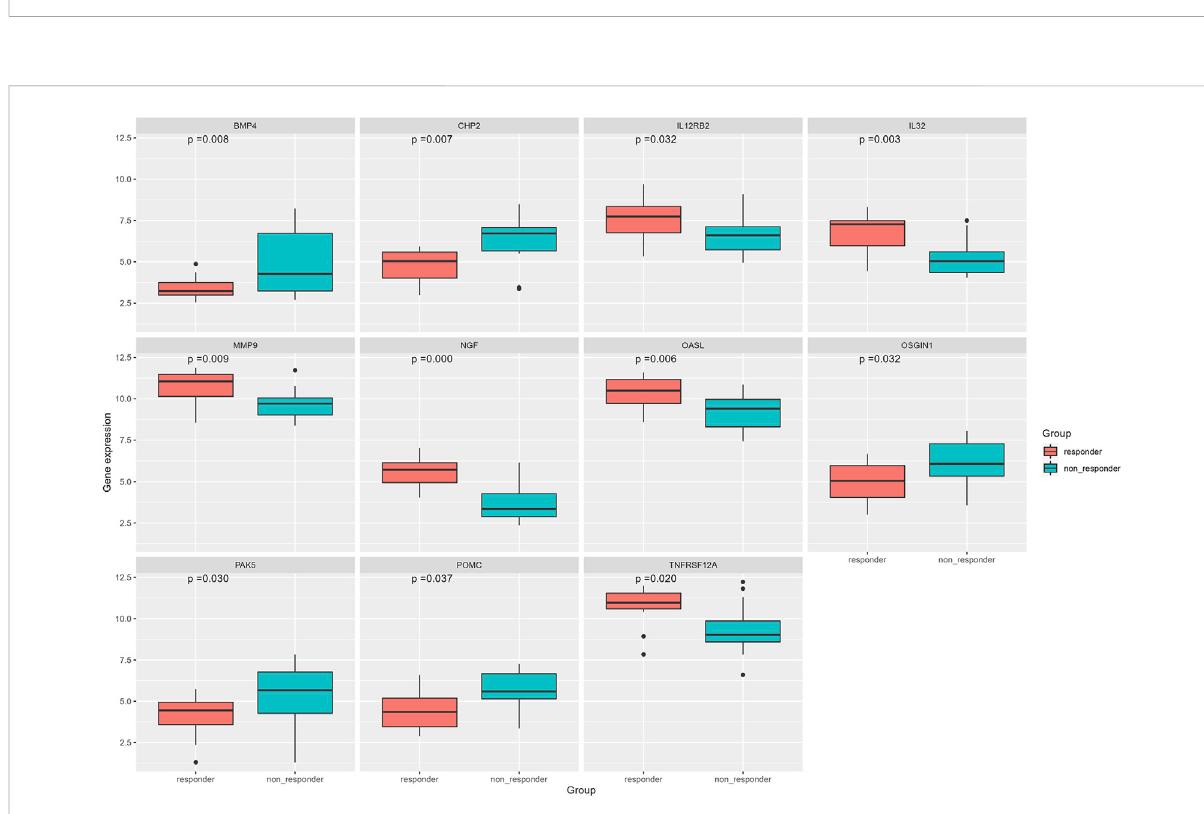
FIGURE 10 Differential expression analysis of immune genes in GSE45670